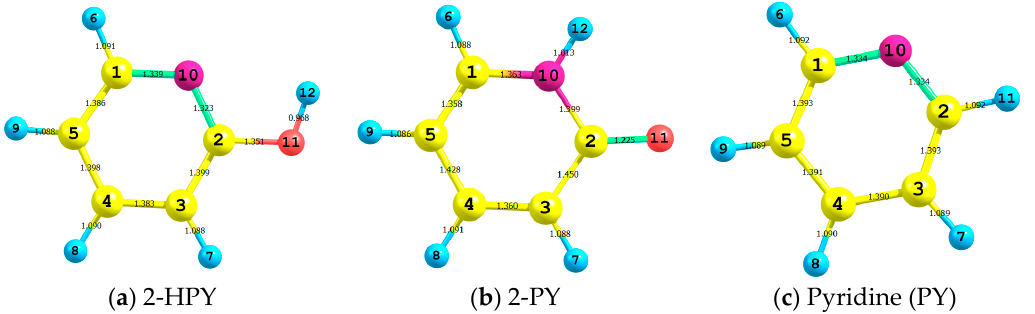
Figure 1. The atom numbering and bond lengths of ( a ) 2-hydroxypyridine (2-HPY); ( b ) 2-pyridone (2-PY); and ( c ) Pyridine which have been obtained at the CAM-B3LYP/aug-cc-pvdz level of theory. The color scheme is pink: nitrogen; yellow: carbon; blue: hydrogen; and red: oxygen.